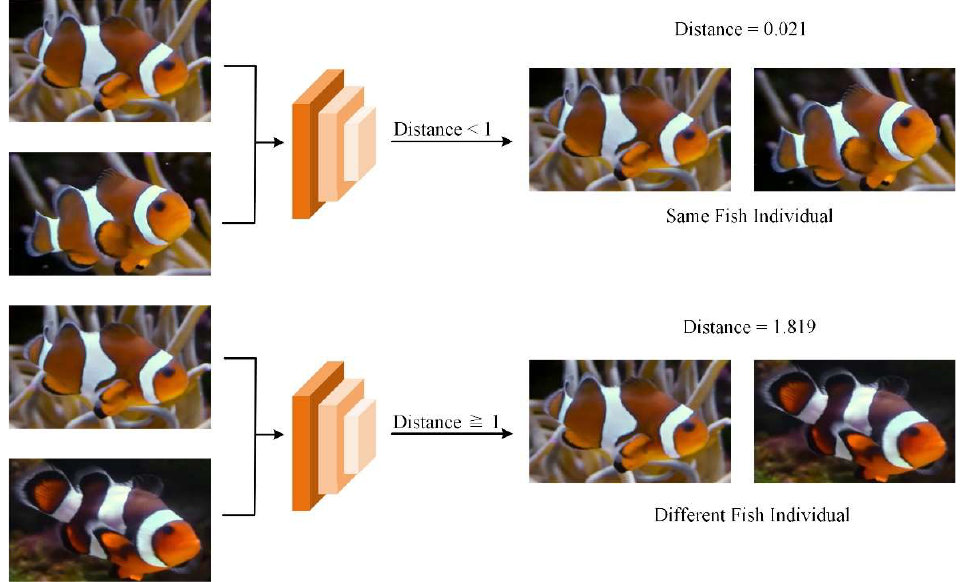
Figure 2. Schematic diagram of individual fish recognition.